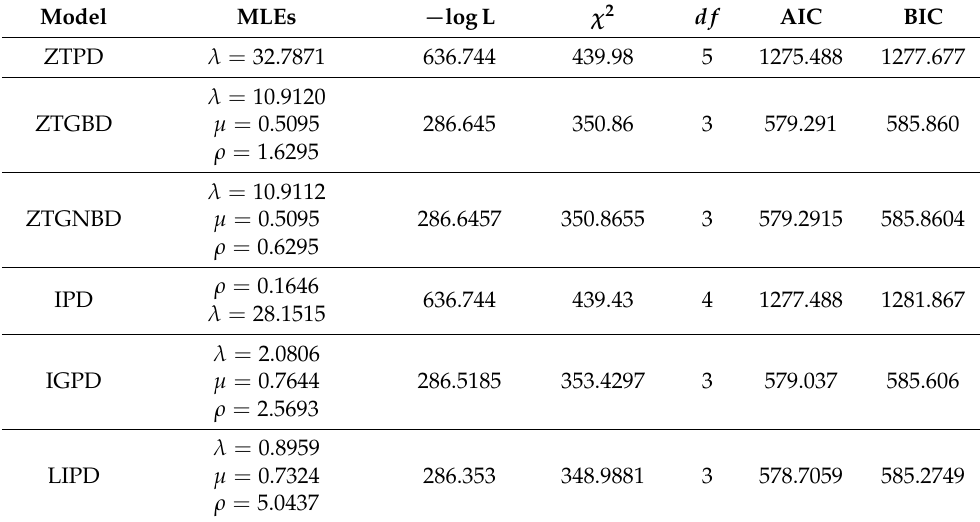
Table 7. MLEs and GOF values for the COVID-19